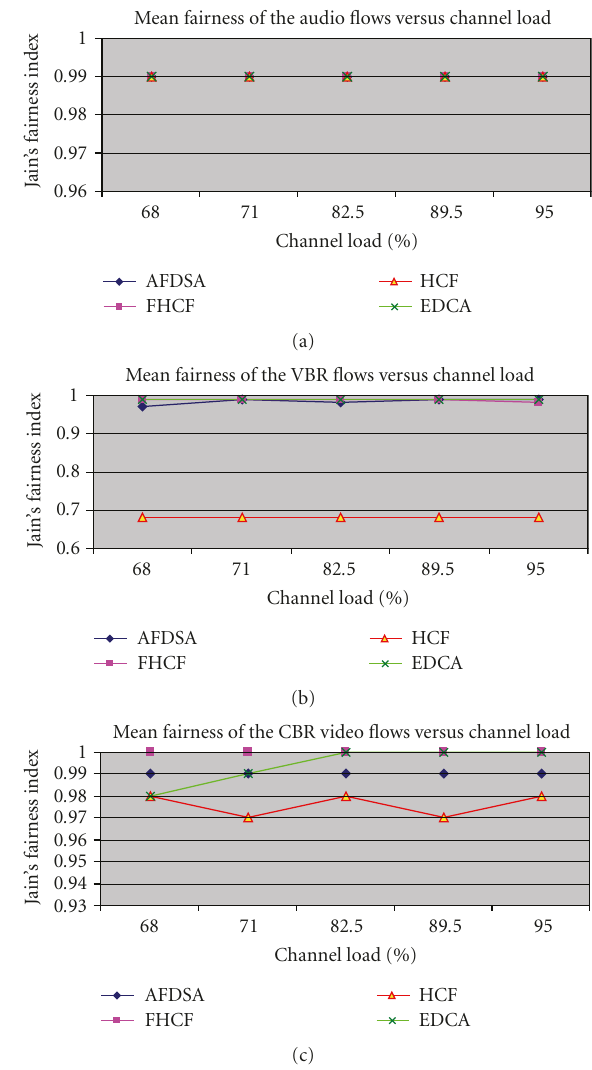
apparent that AFDSA and FHCF are better than EDCA and HCCA for VBR video tra ffi